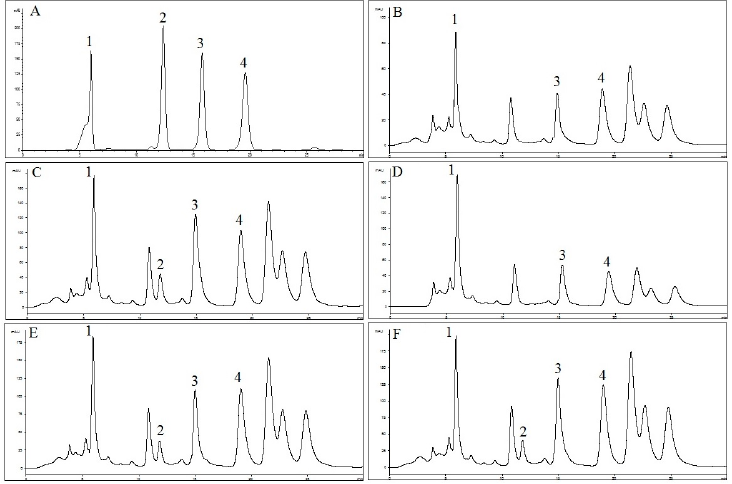
Figure 3. HPLC chromatograms of: ( A ) reference compounds (1: RA; 2: TMF; 3: SIN; and 4: EUP); ( B ) OS-W; ( C ) OS-E; ( D ) OS-M; ( E ) OS-EW; and ( F ) OS-MW at 330 nm. Table 1. Quantification of four marker compounds in OS extracts. Results are shown as average (mg/g; marker compound/extract).